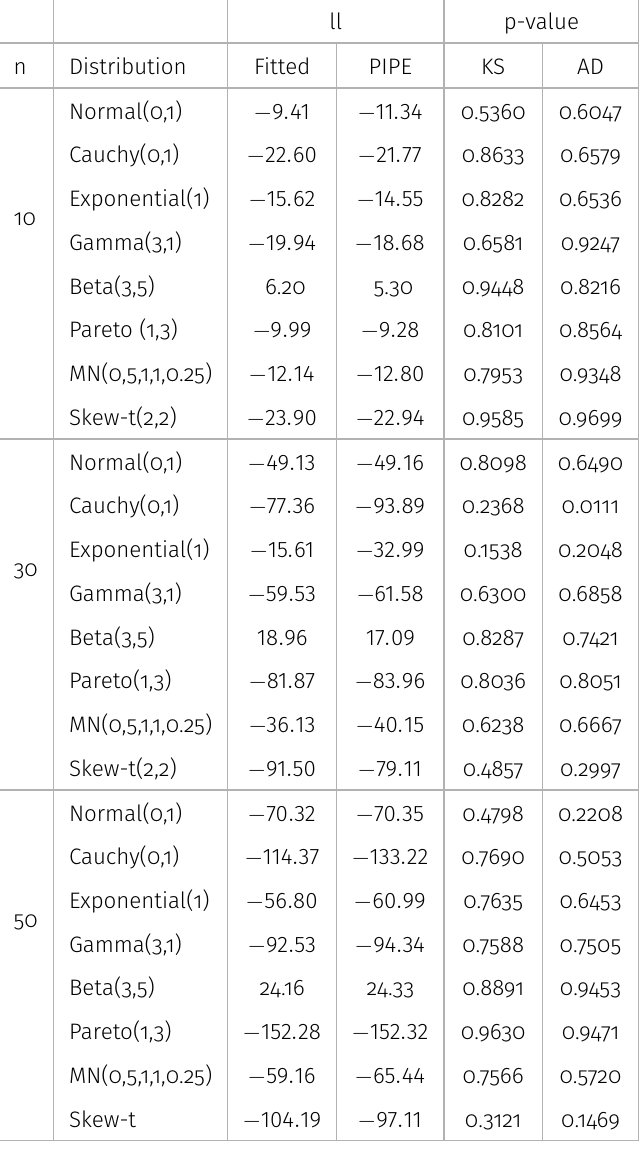
Table I. Results support the PIPE method distribution.